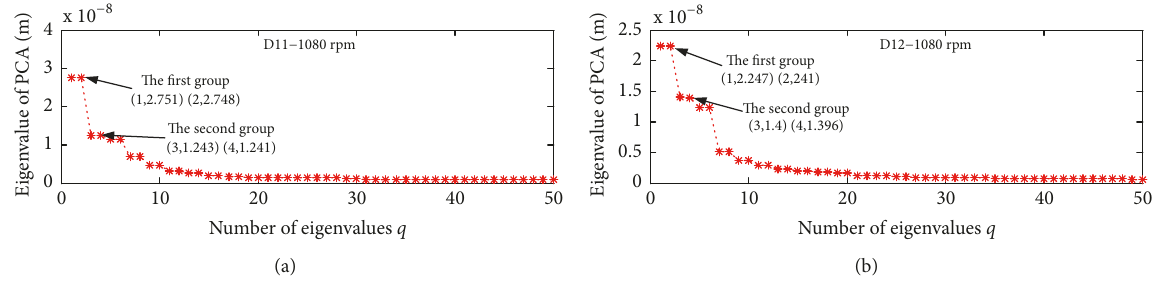
Figure 11: The eigenvalues distribution of covariance matrix C . (a) The eigenvalues distribution of D11 signal. (b) The eigenvalues distribution of D12